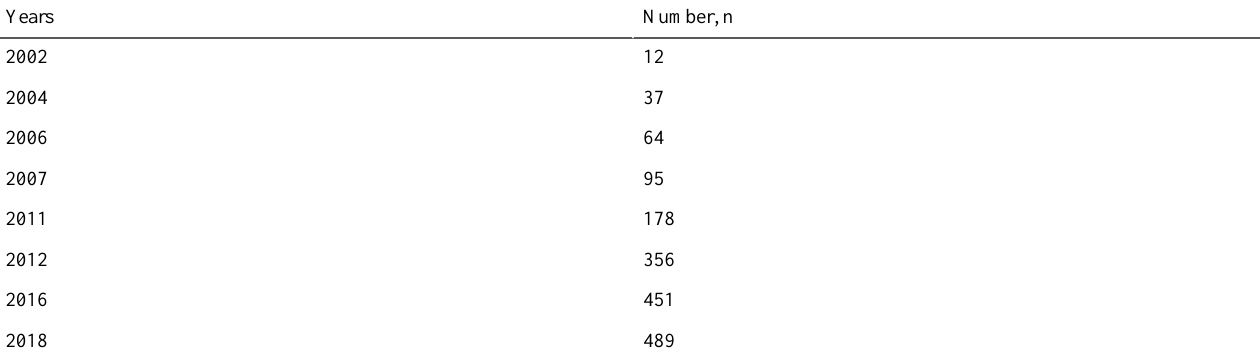
Table 4. The number of ART centers approved by National Health Commission of the People’s Republic of